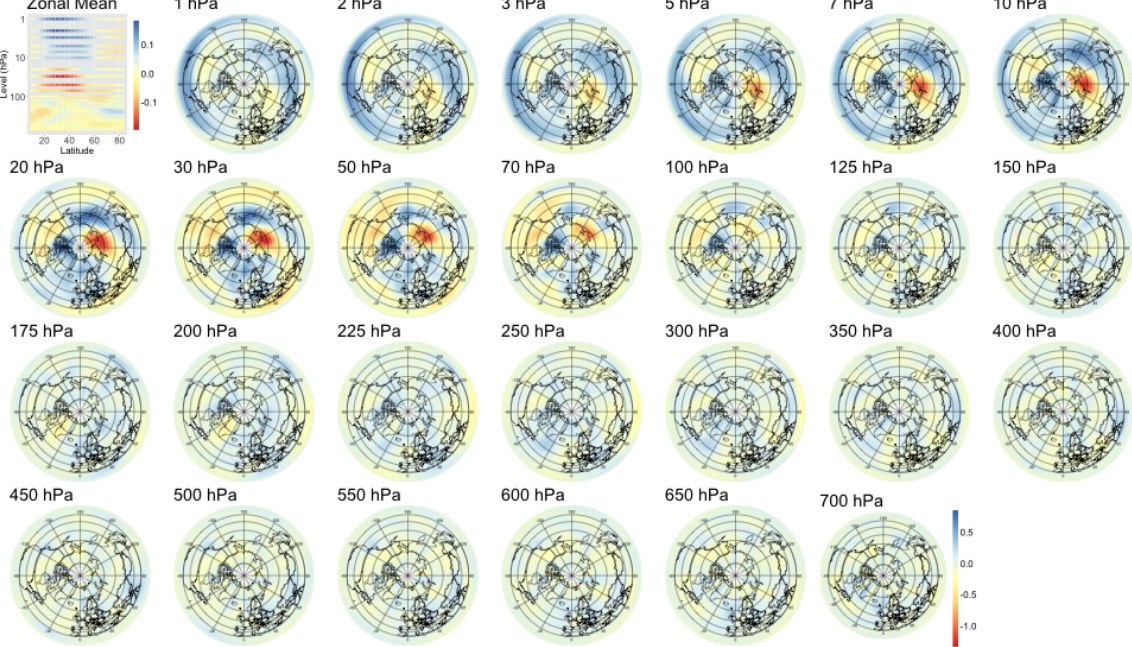
Figure B11. Patterns of heat flux maximizing correlation with the SSW index at a lead time of 6h. The upper-left plot displays the patterns’ zonal averages.